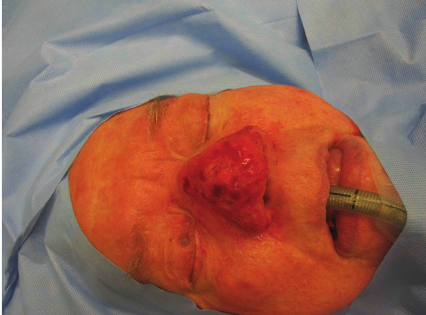
Figure 8: Case 3, intraoperative frontal post reduction.